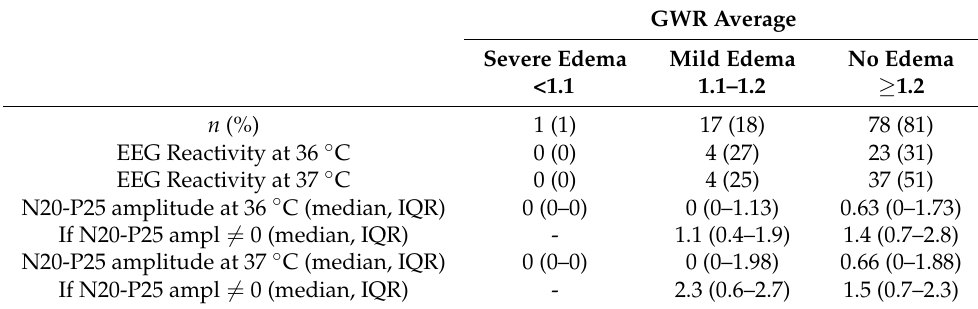
Table 2. Association between GW ratio and SSEP amplitudes and EEG reactivity at different temper- ature.